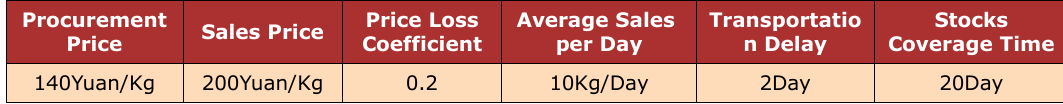
Table 5. The variable and constant value of